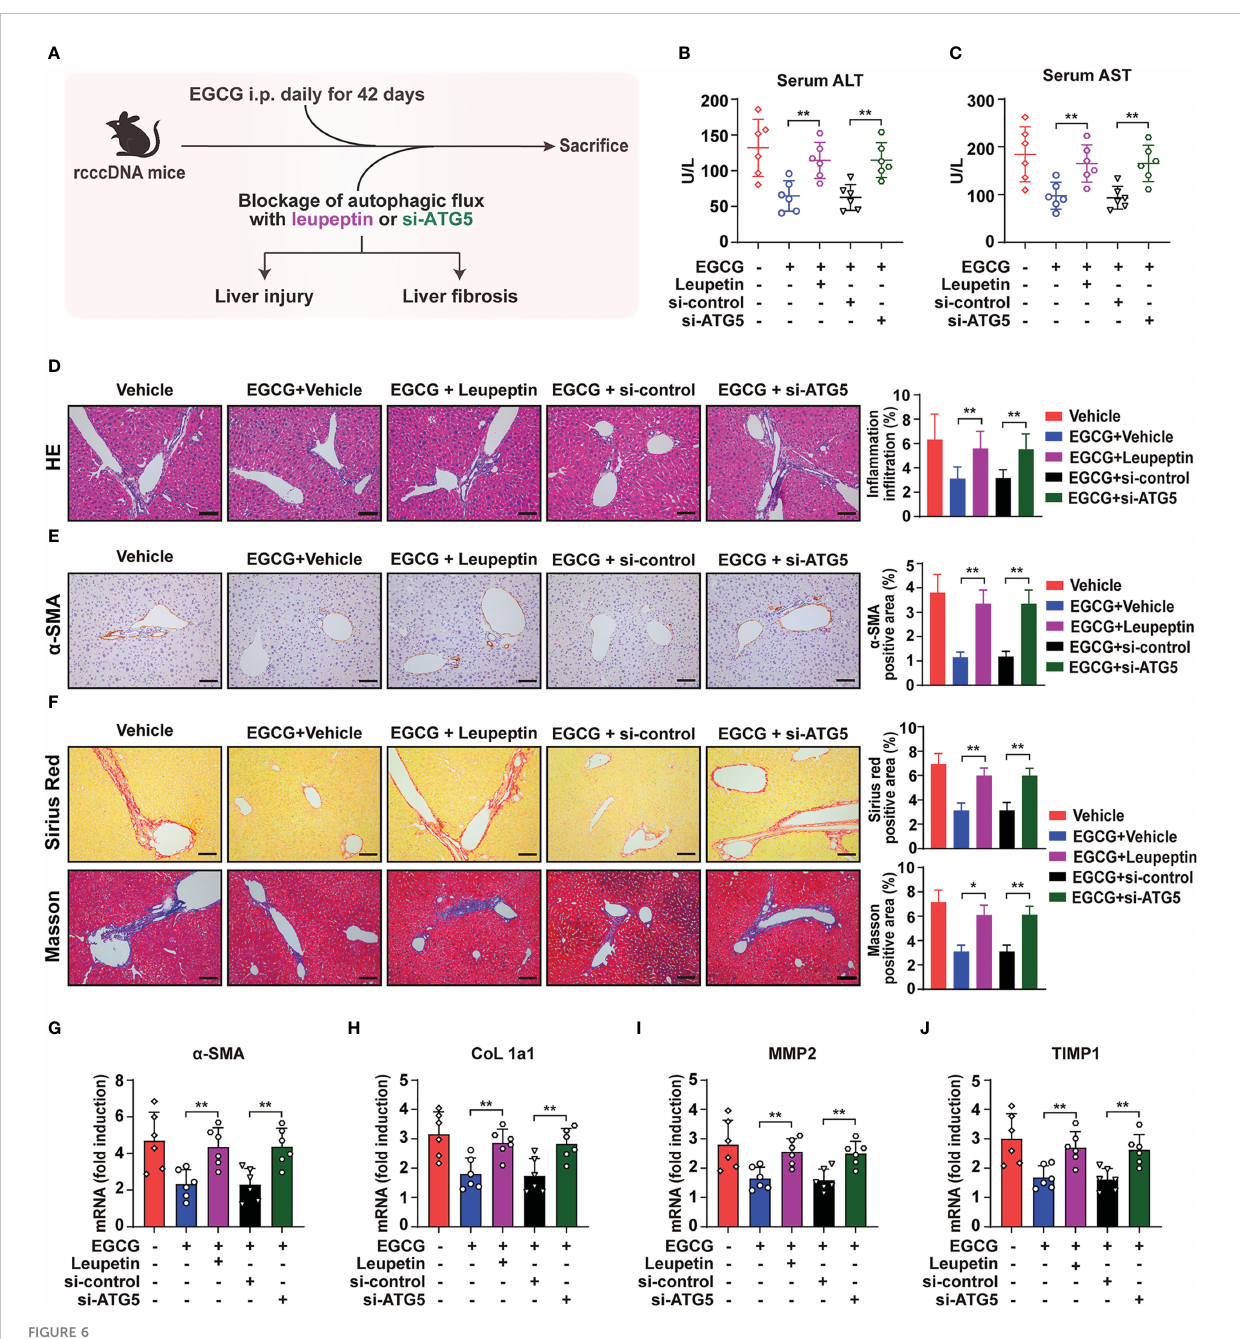
FIGURE 6 Blockage of autophagic fl ux reverses the protective effect of EGCG on HBV-induced liver injury and fi brosis. (A) Schematic illustration of the effect of blockage of autophagic fl ux using leupeptin and si-ATG5 on EGCG-mediated inhibitory effect on HBV-induced liver injury and liver fi brosis in rcccDNA mice (n = 6). (B, C) Levels of ALT (B) and AST (C) in mice sera were determined by the ELISA. (D) Liver in fl ammation in fi ltration was determined by Hematoxylin and eosin (H, E) staining. (E) a -SMA expression level was determined by immunohistochemical staining with DAB (brown). (F) liver collagen deposition was determined by Sirius red staining and Masson ’ s trichrome staining. Quanti fi cation of liver in fl ammation in fi ltration, a -SMA-, Sirius red- and Masson- positive areas were measured in 5 random fi elds of each slide using Image Pro-plus software. Scale bar: 100 m m. (G – J) The mRNA expression levels of a -SMA (G) , CoL 1a1 (H) , MMP2 (I) and TIMP1 (J) were determined by qRT-PCR (normalized to GAPDH). Data are shown as mean ± SEM and compared by unpaired Student ’ s t test or one-way analysis of variance (ANOVA). * P < 0.05, ** P <